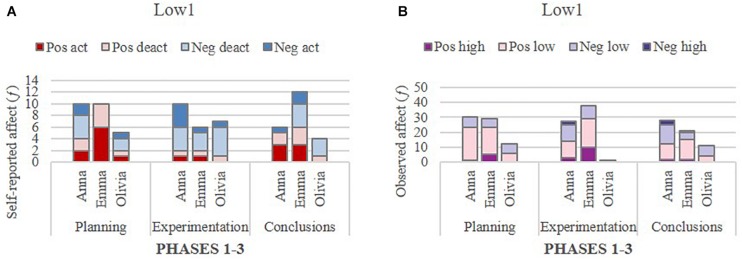
Self-reported (A) and observed (B) affect in the group Low1.